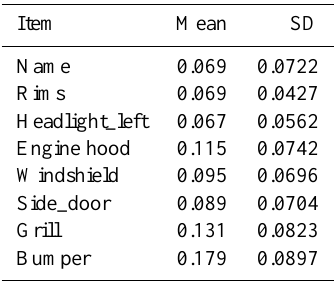
Table 1. Time ratio for the most relevant product attributes.